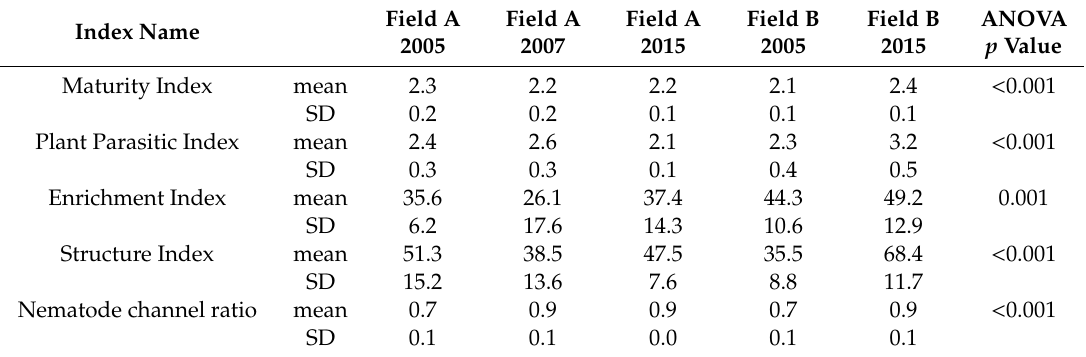
Table 2. Summary mean, standard deviations (SD) and corresponding ANOVA p values from the Nematode INdicator Joint Analysis (NINJA) of the field analysed samples from 2005, 2007 and 2015 in field A and 2005 and 2015 in field